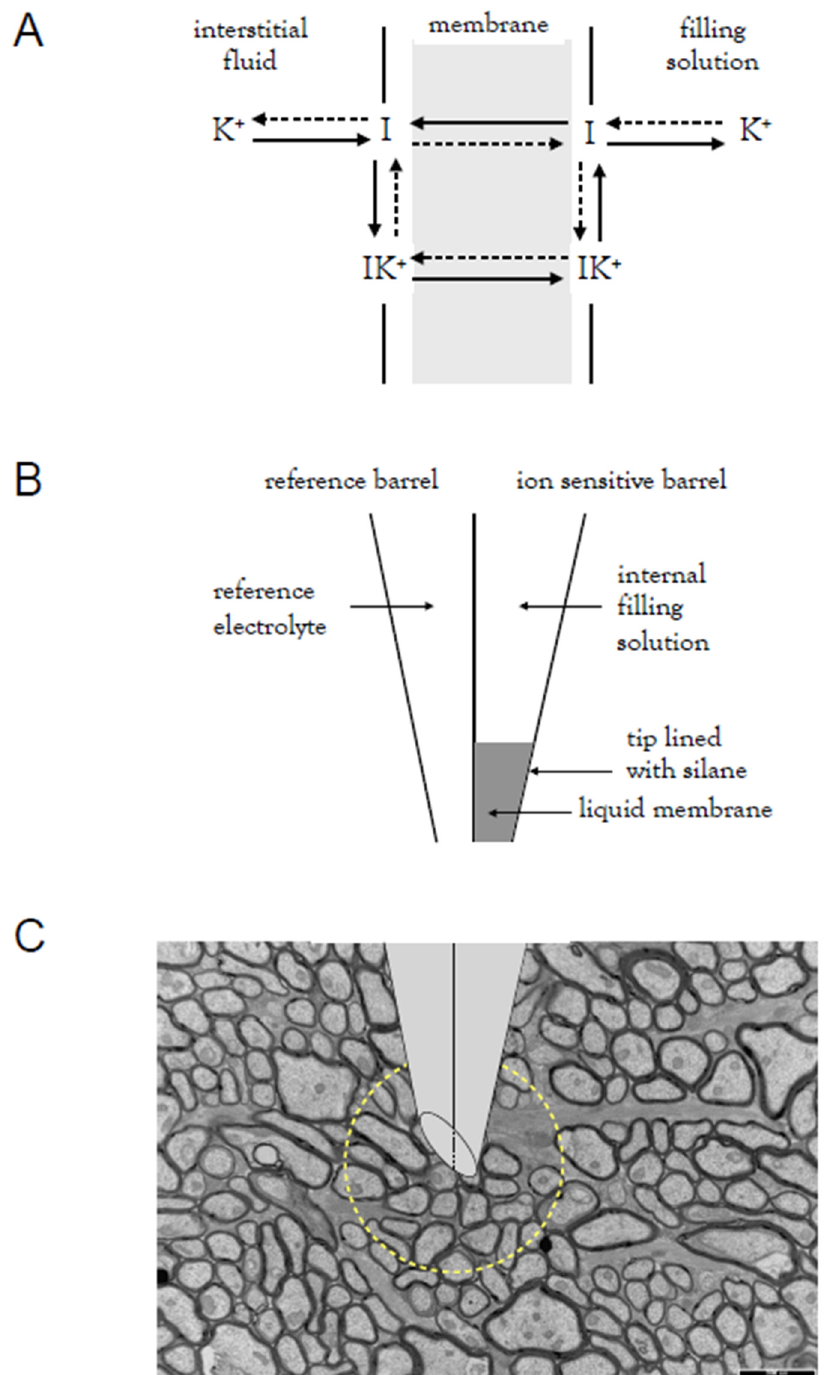
Figure 3. Ion-sensitive microelectrodes. ( A ) The liquid membrane is highly selective for K + and extracts the ion from bulk solution, in the case of an experiment, from the interstitial fluid and by carrier translocation deposits the K + to the internal filling solution compartment. ( B ) Diagram of double-barrelled ISM showing the reference barrel on the left filled with reference electrolyte, and the resin-filled barrel on the right. The silanised tip retains the hydrophobic resin. ( C ) Electron micrograph of adult mouse optic nerve shown in transverse section. The scale bar is 2 µm. All axons in the adult animal are myelinated. The appropriate dimensions of the tip of an ISM have been superimposed. The yellow circle encloses an assumed volume of interstitial fluid adjacent to the tip of the ISM.